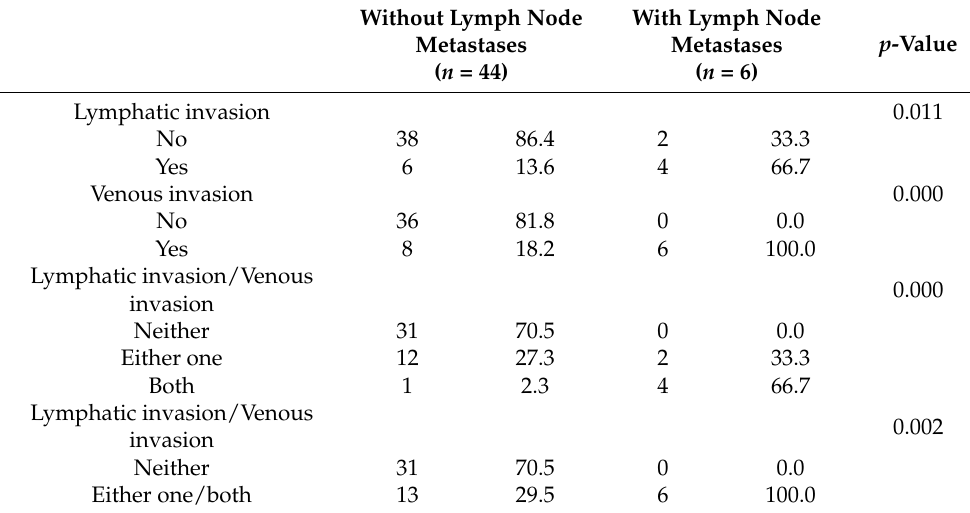
Table 4. Comparison of cases with and without lymph node metastases.